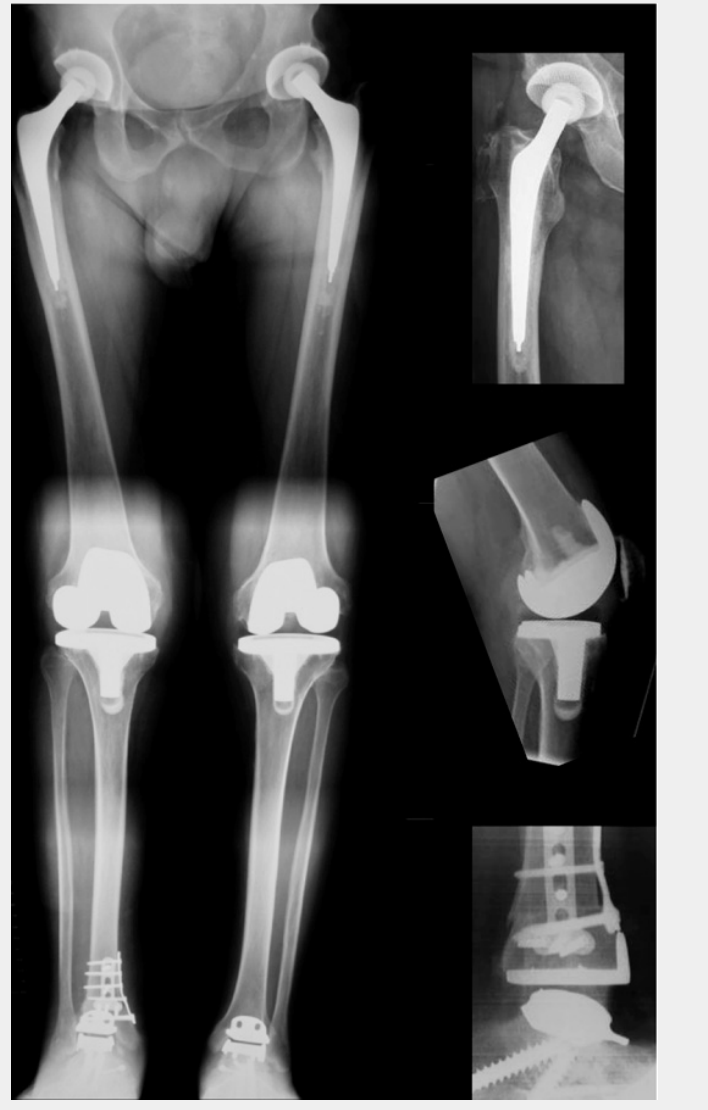
Figure 7 Multi-level surgery: 53 year old patients with rheumatoid and psoriasis arthritis, consistent of two total hip arthroplasties, two total knee arthroplasties, realignment surgery of the right ankle, and two total ankle